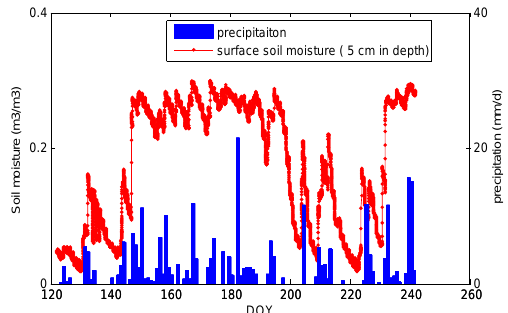
Fig. 7. Seasonal change in surface soil moisture measured at 5cm in depth and rainfall estimated by Chinese meteorological office. Soil moisture measurement method was described by previous publica- tion (van der Velde et al.,